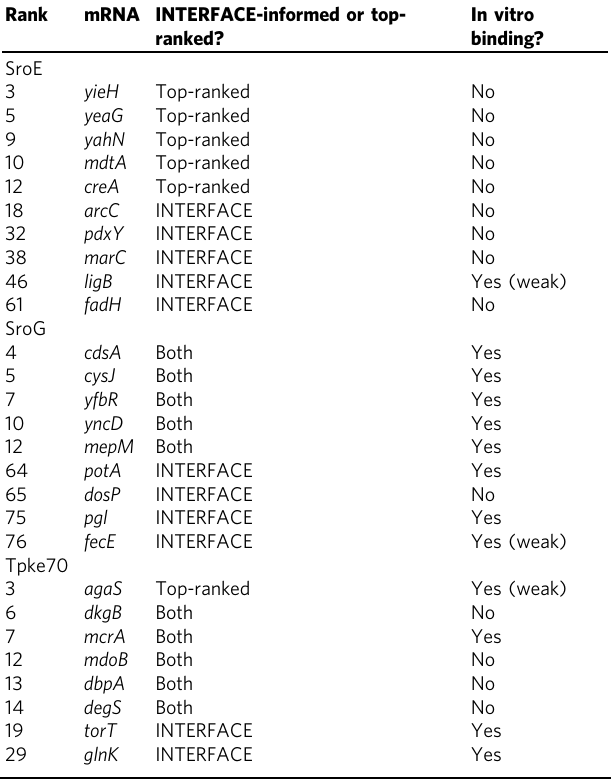
Table 1 Rank, name, and in vitro binding results for three representative uncharacterized sRNAs Rank mRNA INTERFACE-informed or top-